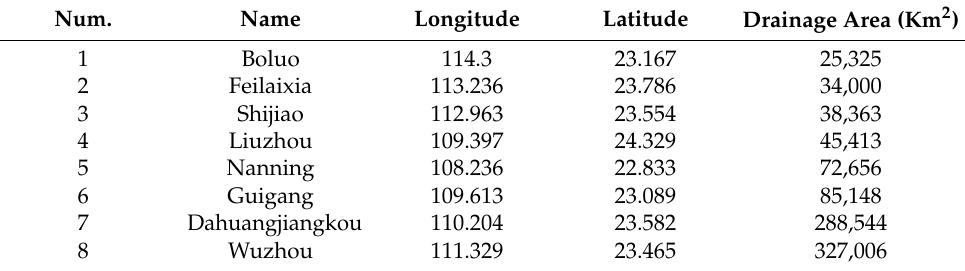
Table 1. Information of main hydrological stations in the PRB.